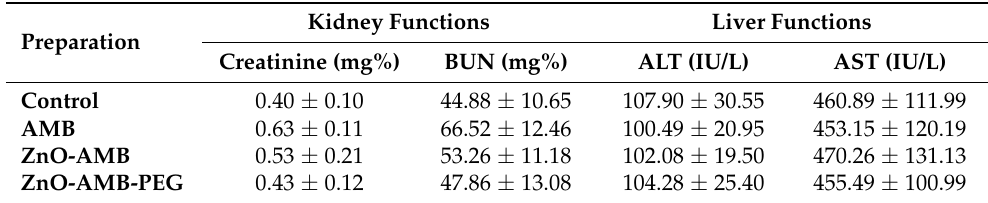
Table 4. Biochemical parameters on post-injection effects. Preparation